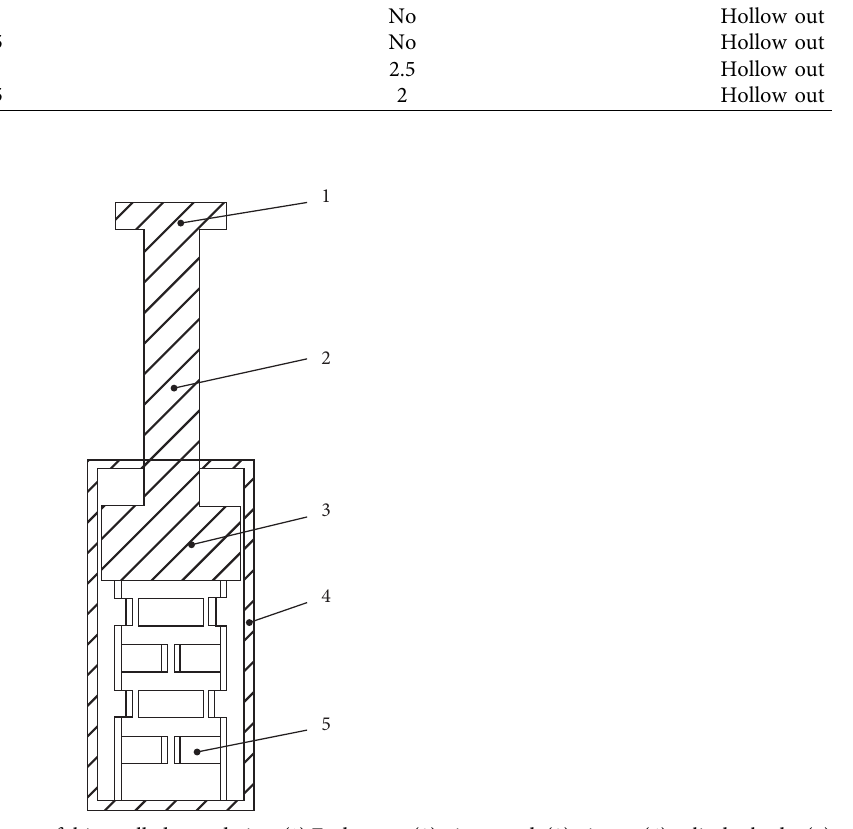
Figure 2: Installation plan of crushed components of thin-walled round pipe. (1) End cover, (2) piston rod, (3) piston, (4) cylinder body, (5) crushing